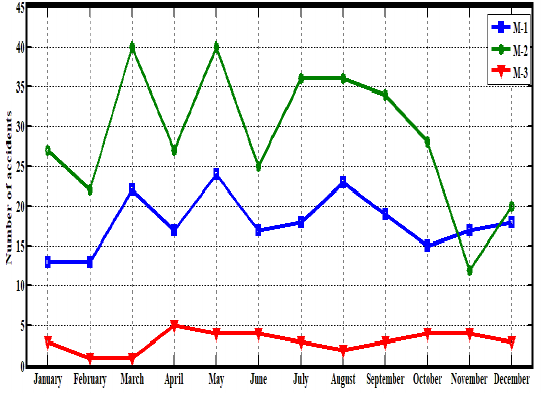
Fig. 4: Difference of road accidents by months (M1, M2 and